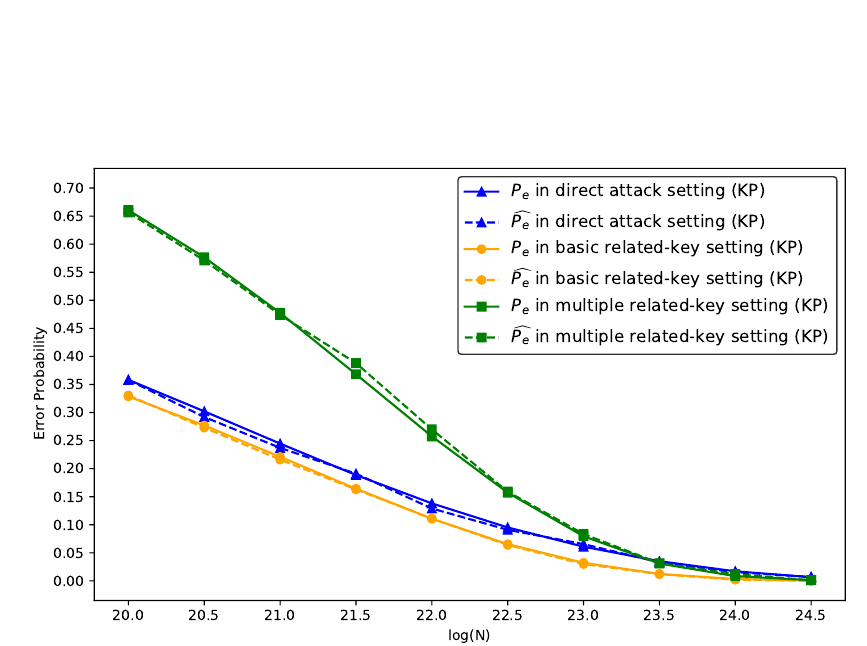
Figure 5: Comparison of error probabilities using the MLE-based models described in Sect. 3.2.